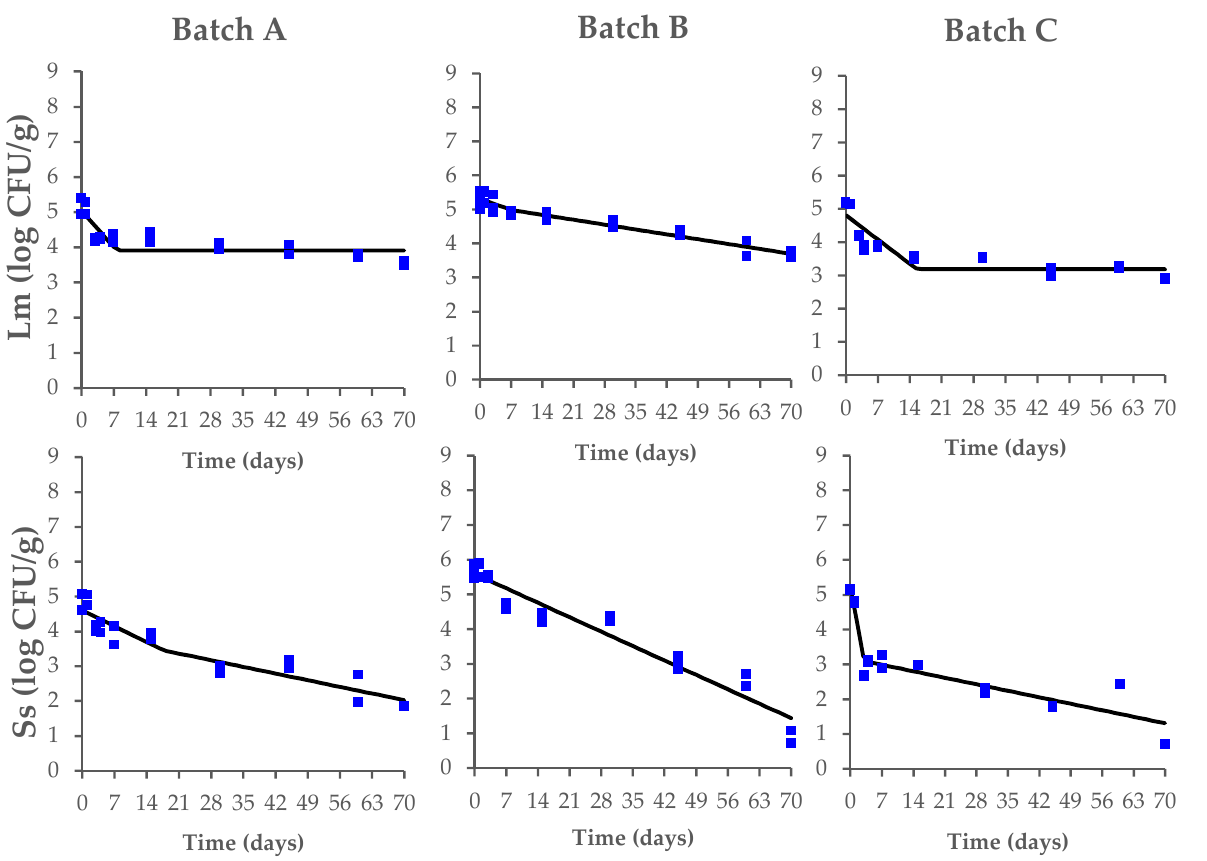
Figure 3. Behavior of L. monocytogenes (Lm) and Salmonella spp. (Ss) during the production process of Milano-type salami made from Batch A (basic recipe), Batch B (vegetable nitrates), and Batch C (synthetic nitrates/nitrites). The observed data (square symbols of two replicate samples for each batch) were fitted using a biphasic model. The black line is of visual interest only.